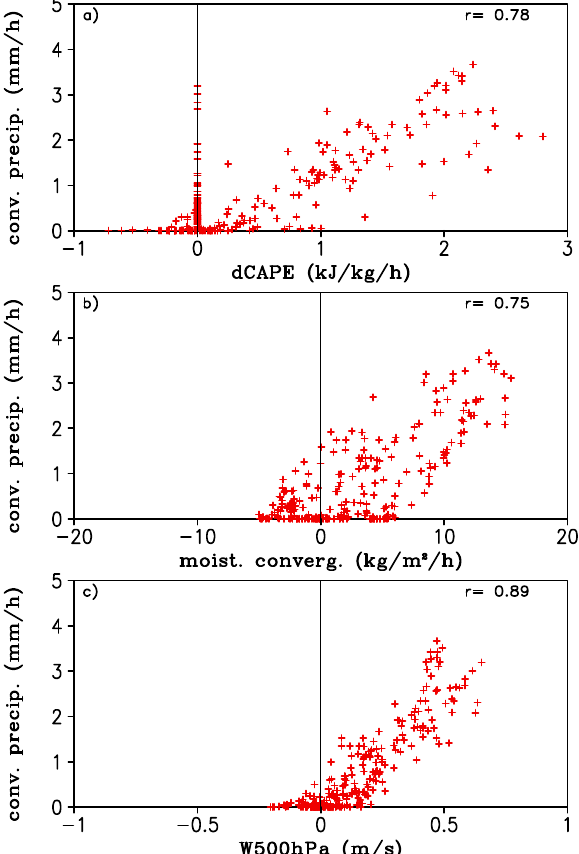
/ h)against( a )verticalvelocityat500hPa(m / s), Figure 9. Same as Figure 7 but over 128 km subdomain. Figure9. Scatterplotsofconvectiveprecipitationrate(mm ( b ) moisture convergence (kg / m 2 / h), and ( c ) large-scale CAPE change (kJ / kg / h) over 128 km subdomain. The lead-lag correlation between convection and large-scale forcing is shown in Figure